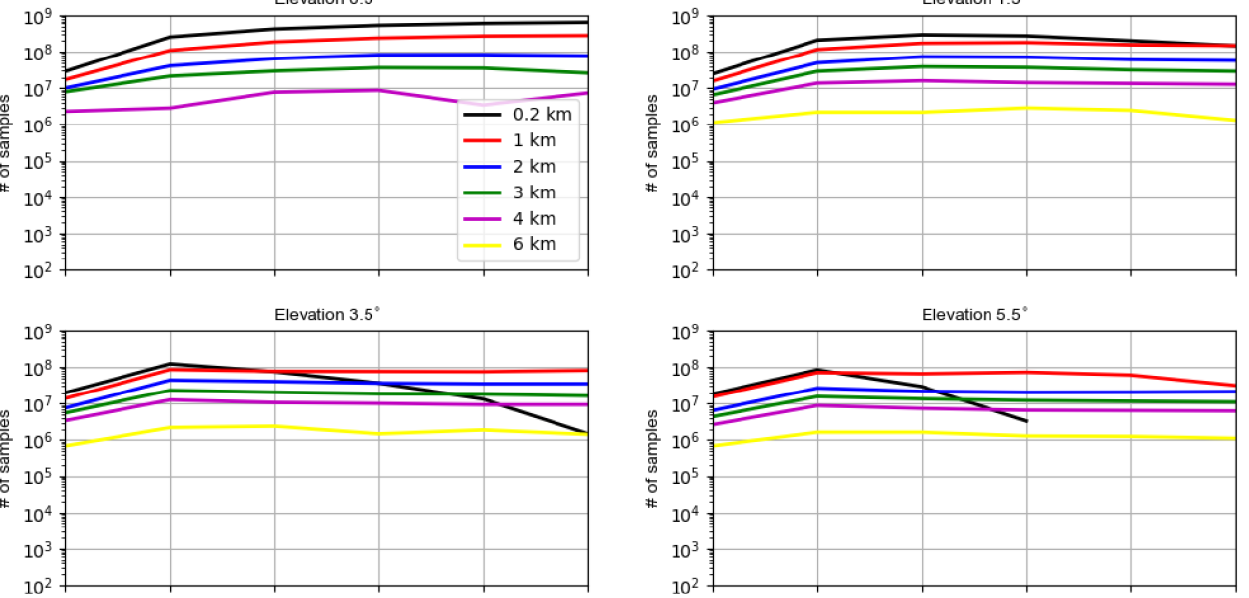
Figure A2. The numbers of samples used for estimating horizontal correlations for the RE of reflectivity data ≥ 5dBZ for elevations of 0 . 5, 1 . 5, 3 . 5 and 5 . 5 ◦ at heights of 0.2, 1.0, 2.0, 3.0, 4.0 and